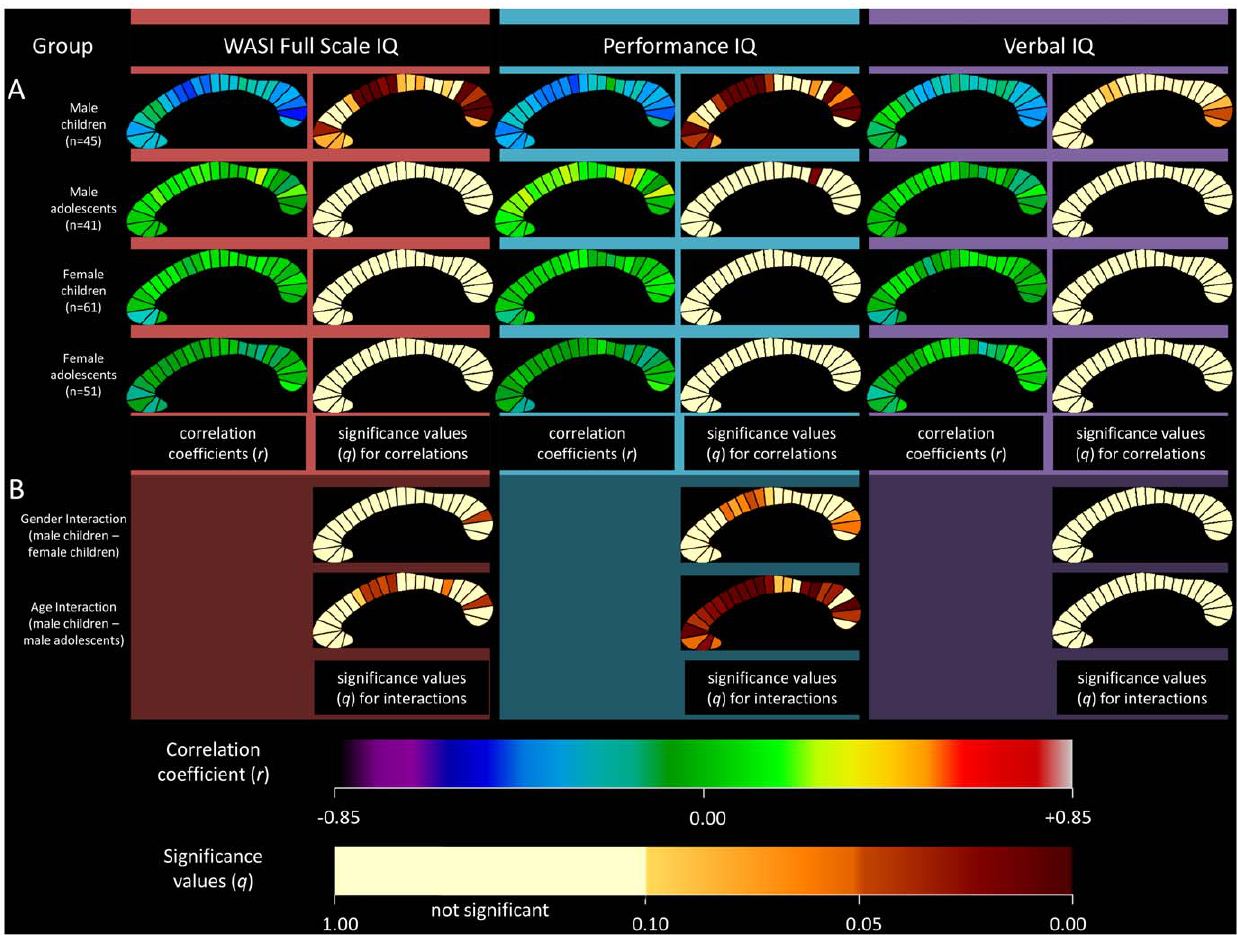
Figure 5. Correlations between corpus callosum midsagittal area and IQ: combined sample and sample partitioned by age and gender. A. Partial correlation coefficients and associated significance values for Full-Scale IQ measurements are shown in the first and second columns of callosal maps. Correlation coefficients and associated significant values for Performance IQ are shown in the third and fourth columns, and for Verbal IQ in the fifth and sixth columns. The male children are shown in the first row, the males adolescents in the second row, the female children in the third row, and the female adolescents in the fourth row. B. Gender and age interactions. Gender interaction in children is shown in the first row and age-group interaction is shown in the second row. The upper color bar encodes the r -values that depict the magnitude and direction of correlations, and the lower color bar encodes the level of significance for the correlation coefficients and the interactions.